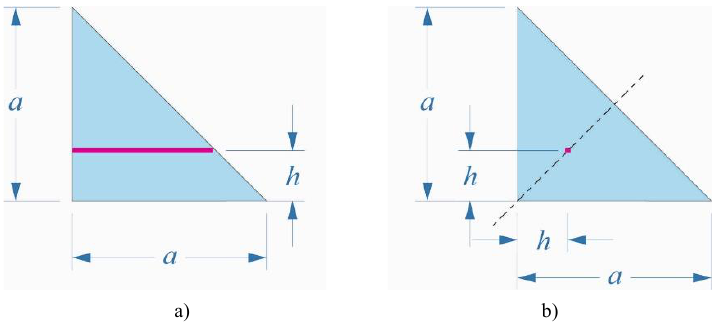
Fig. 12 Considered triangular DGU under a) line and b) concentrated load.